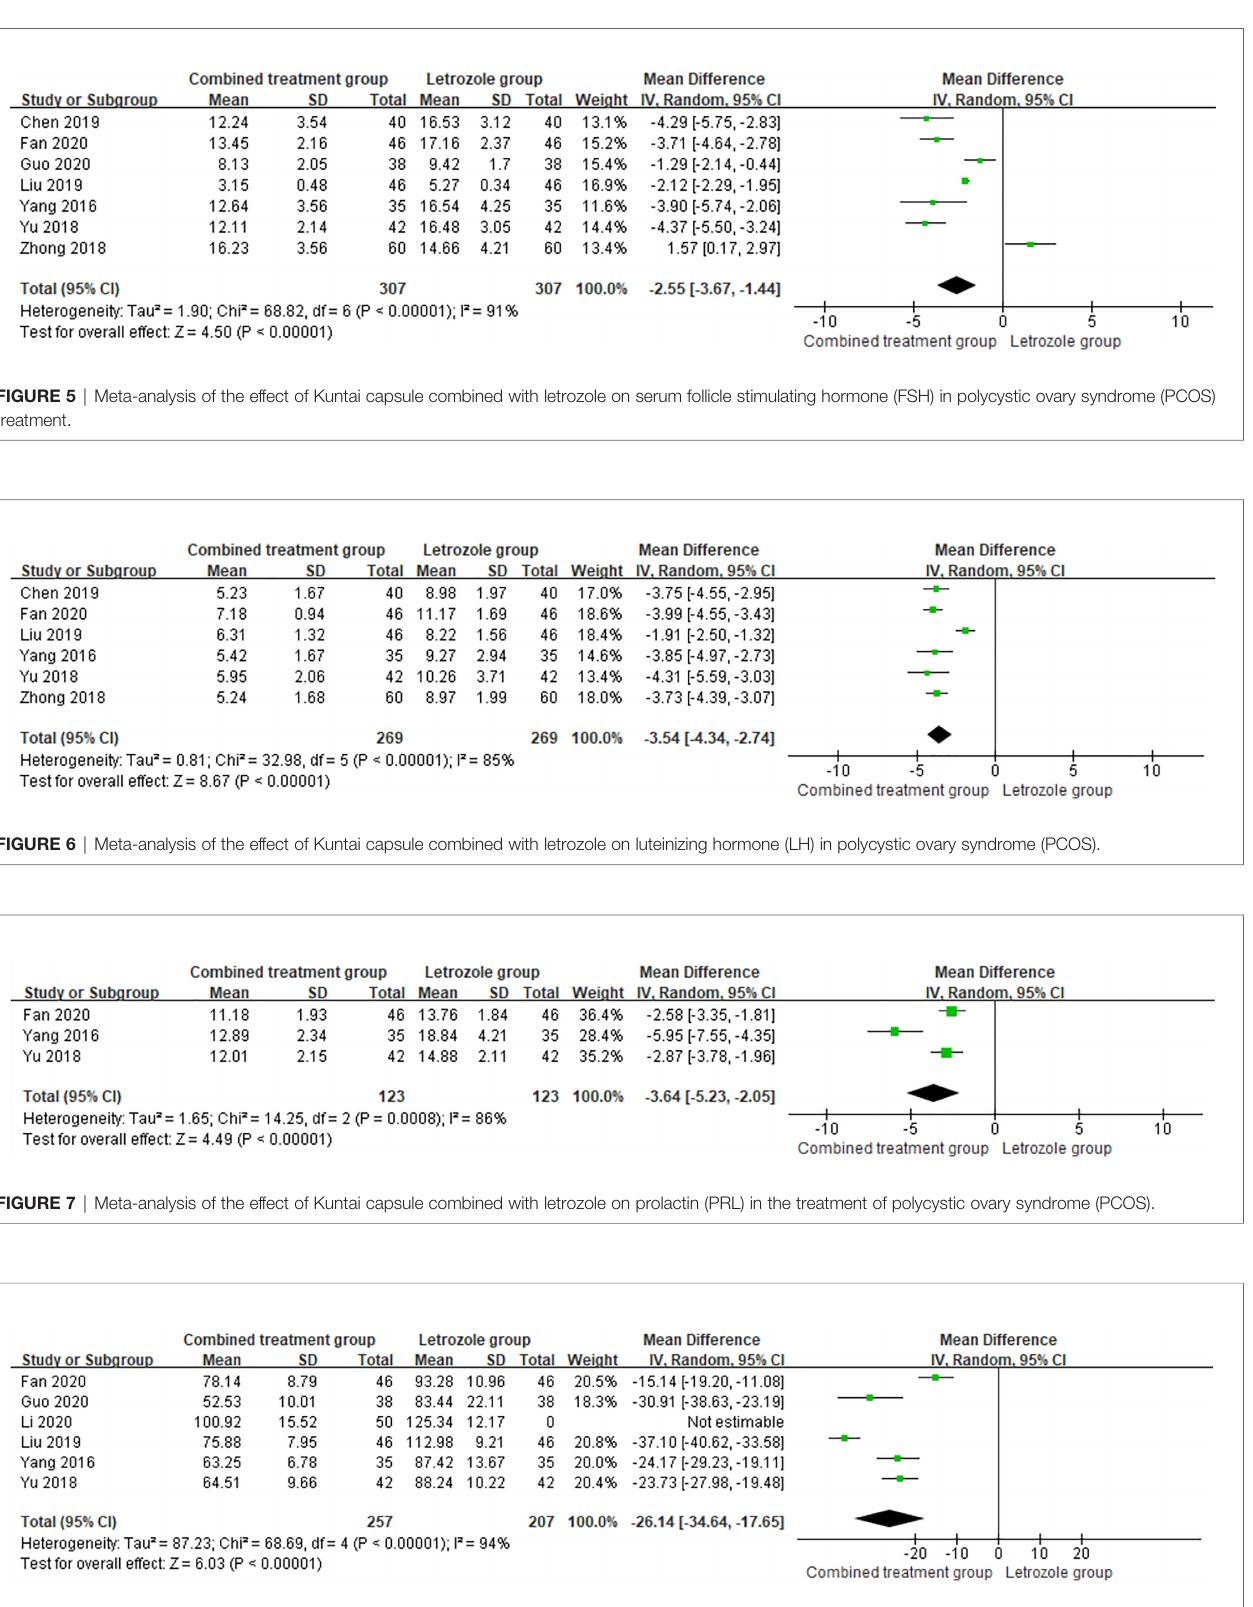
FIGURE 8 | Meta-analysis of the effect of Kuntai capsule combined with letrozole on estradiol (E2) in polycystic ovary syndrome (PCOS) treatment.